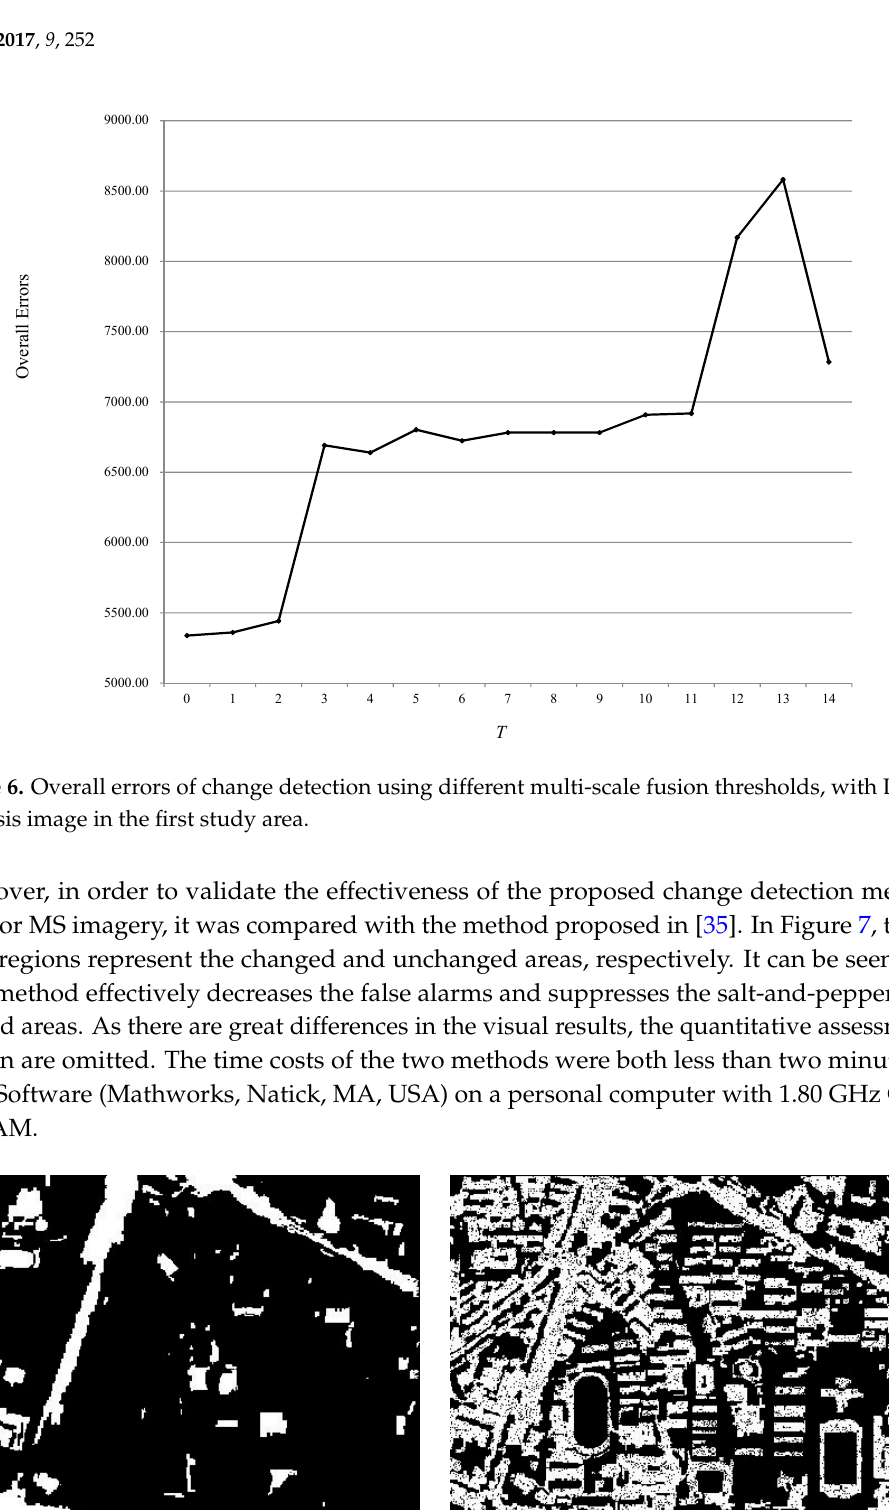
Figure 7. Change detection maps resulting from ( a ) the proposed multi-scale k -means method and ( b ) the method using varying geometric and radiometric properties [35], with L2 as the basis image in the first study area (scale = 100).